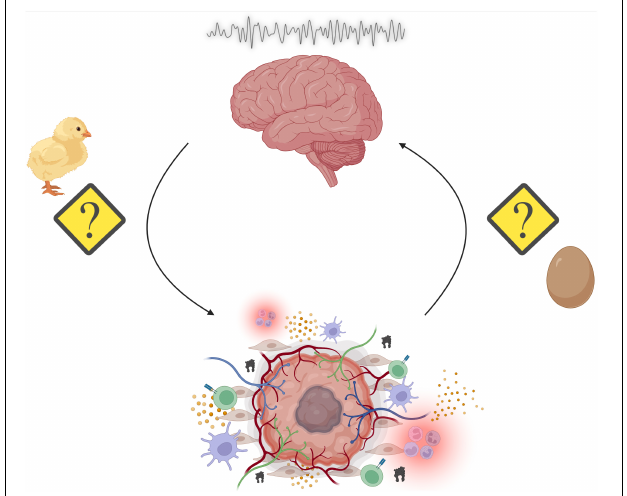
FIGURE 3 | Summary of the overarching principles highlighted in this review. Sleep disruption may promote tumorigenesis through alterations in a variety of physiological processes such as energy balance, immunity, and stress. Reciprocally, the genesis of peripheral tumors and the subsequent assembly of the tumor microenvironment (TME) results in cancer-mediated alterations to our physiological processes. The consequences include aberrant neural activity, which affect a multitude of behavioral outputs including disruption of sleep/wake cycles. This results in a “chicken or the egg” phenomenon, where it is unclear whether sleep disruption promotes cancer or cancer reciprocally disrupts sleep (Made with